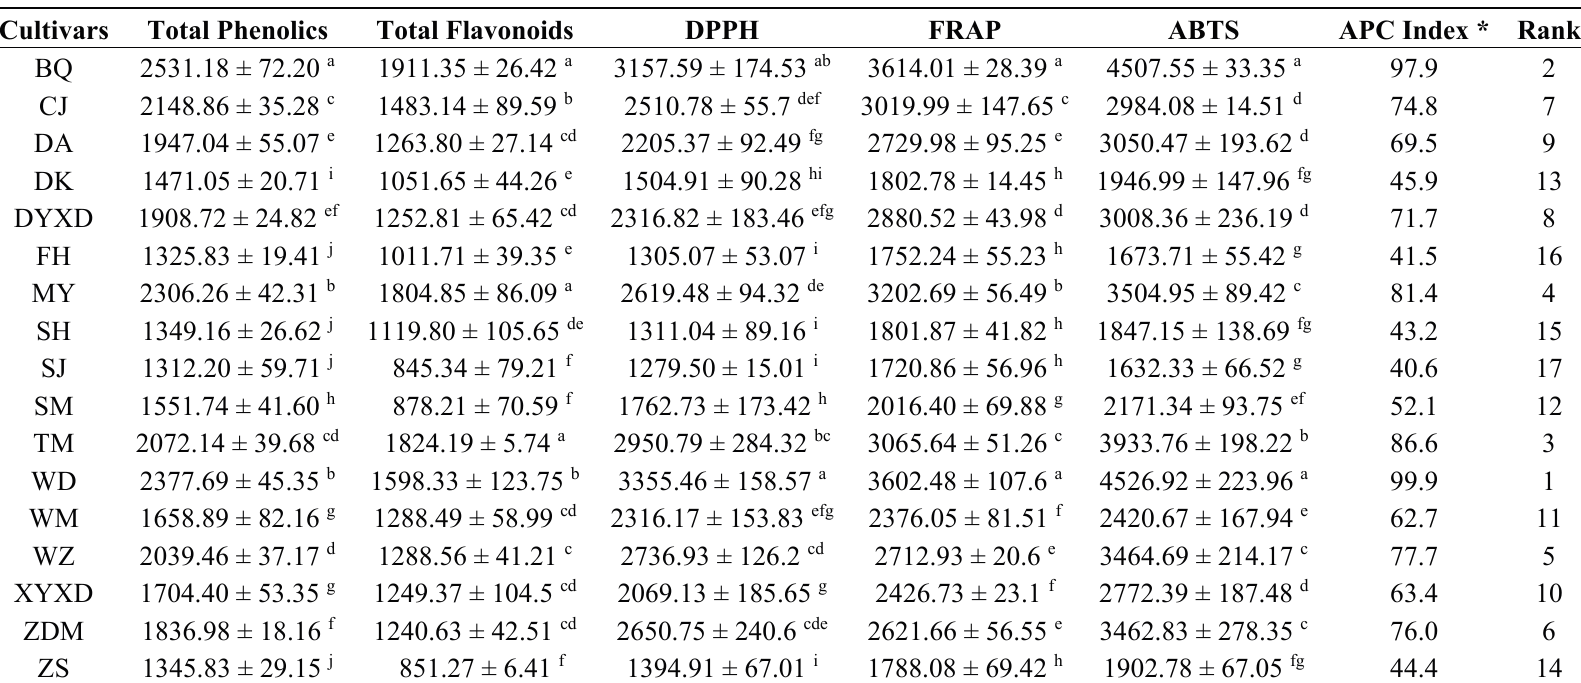
Table 2. Total phenolics, total flavonoids and antioxidant capacities of Chinese bayberry fruits of 17